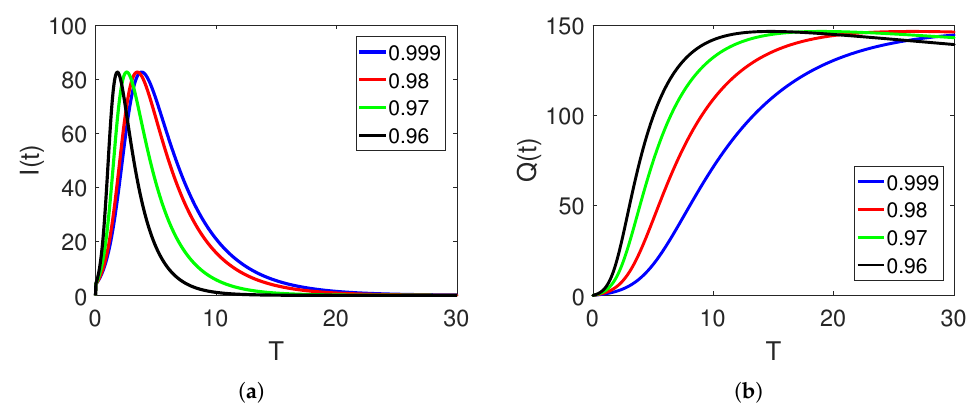
Figure 2. Dynamics of the infected class ( a ) and quarantined class ( b ) on different arbitrary fractional order ς on sub interval [ 0, t 1 ] and [ t 1 , T ] of [ 0, T ] .